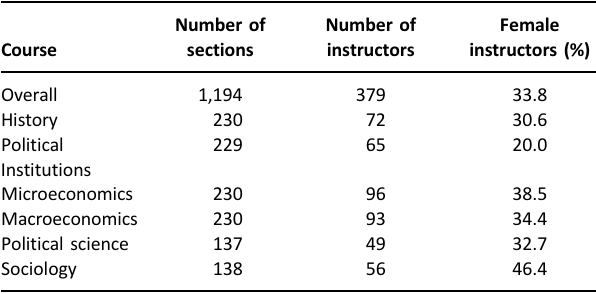
Table 1. Summary statistics of